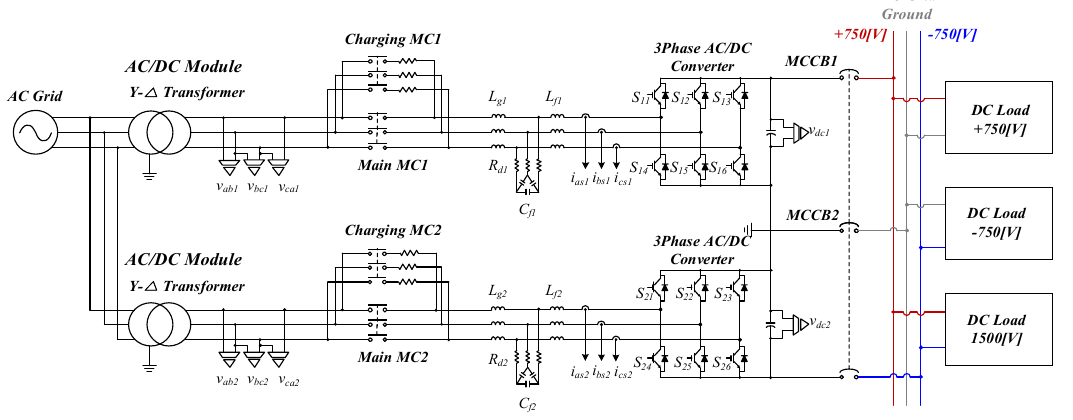
Figure 2. Proposed configuration of a bipolar low voltage DC (LVDC) distribution system.